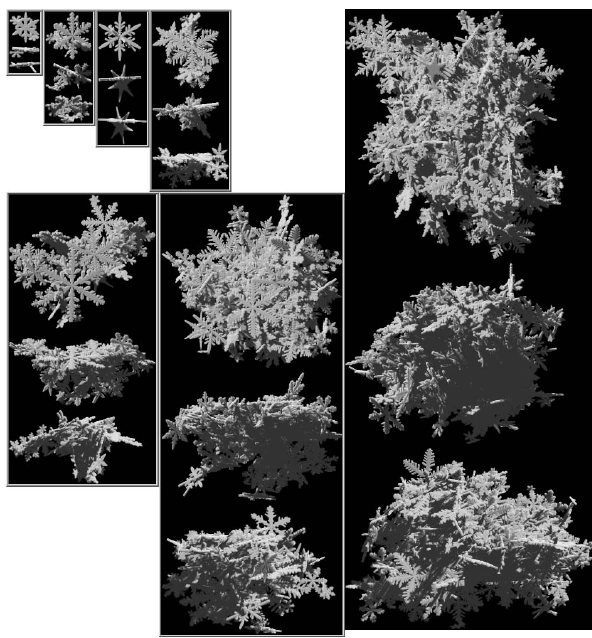
Fig. B2. Images showing seven snowflake aggregates, each from three perspectives: view of X-Y plane (top panel), view of X-Z plane (middle panel), and view of Y-Z plane (bottom panel). A solar pseudo-radiative transfer rendering is used; the solar illumination is from the upper left at 45 ◦ zenith angle. The equivalent volume di- ameters of these aggregates are 254, 369, 321, 510, 854, 1315, and